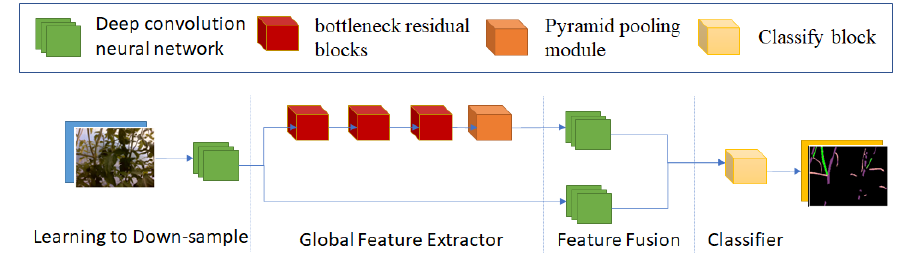
Figure 6. Fast-SCNN structure.